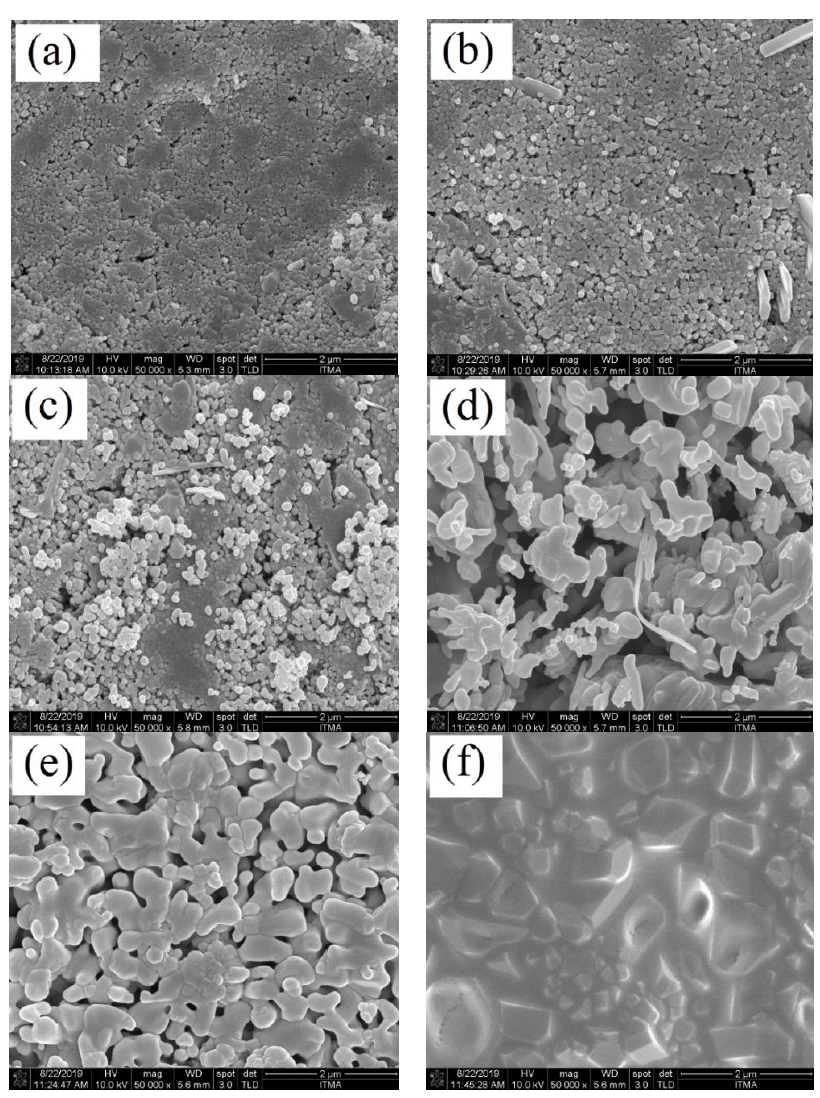
Figure 3. Field emission scanning electron microscopy (FESEM) images of composite sample ZnO-SiO 2 at ( a ) RT, ( b ) 600 °C, ( c ) 700 °C, ( d ) 800 °C, ( e ) 900 °C, and ( f ) 1000 °C.